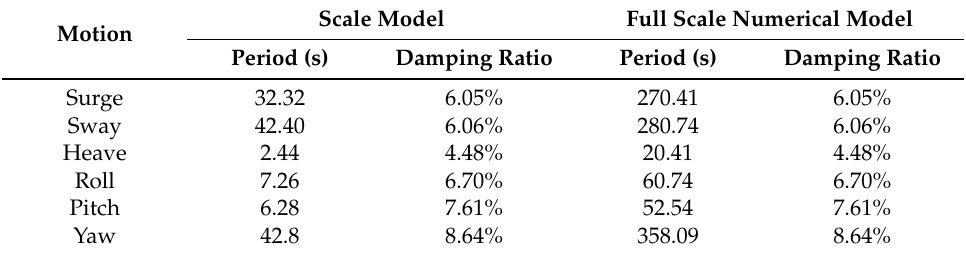
Table 2. The identification results of the natural period and the damping ratio in free-decay